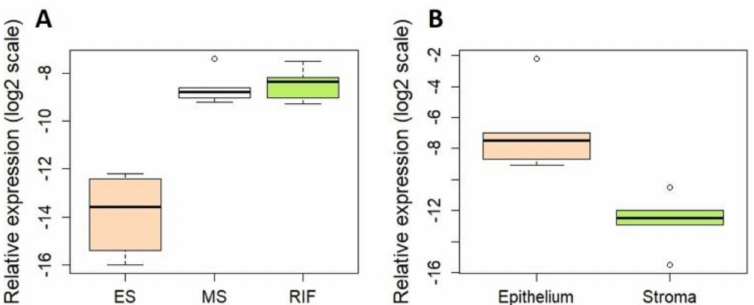
Figure 3. Validation of the novel miRNA chr2_4401 by quantitative real-time polymerase chain reaction (qRT-PCR). ( A ) miRNA expression level differences between paired ES ( n = 8) and MS ( n = 8) endometria of fertile women, and MS endometria of RIF ( n = 8) patients. The relative miRNA expression levels ( ∆ Ct) in the endometrium were 37-fold higher in MS compared to ES samples ( p = 0.0001). No differences between MS samples of fertile and RIF patients were observed. ( B ) Relative expression level differences in epithelial ( n = 5) and stromal ( n = 5) fractions. The relative miRNA levels ( ∆ Ct) were 55-fold higher in epithelial cells (CD9+) compared to stromal cells (CD13+) ( p = 0.003). The average levels of miR-151a-5p and miR-196b-5p were used for data normalization. For illustrative purposes, relative expression levels ( ∆ Ct) were multiplied by − 1. ES—early secretory phase; MS—mid-secretory phase.